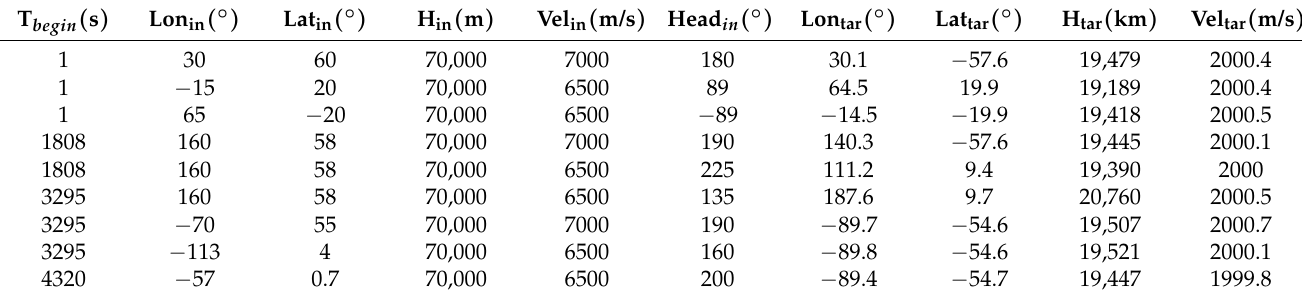
Table A3. HGV parameter